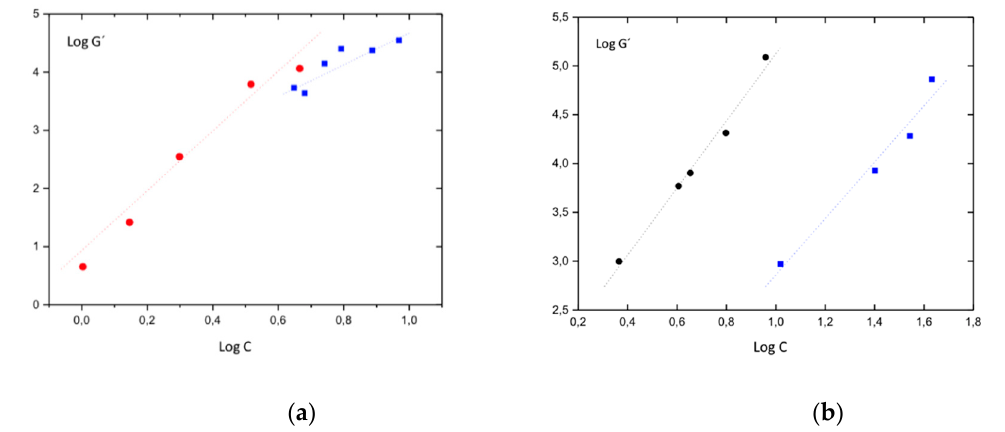
Figure 6. ( a ) Double logarithmic plot of the equilibrium storages modulus plateau as a function of metallo-organic polymer concentration for hybrid gels with a fixed iPS concentration of 4%, g/mL (blue square) and for pure metallo-organic polymer gels (red circle) and ( b ) as a function of iPS concentration